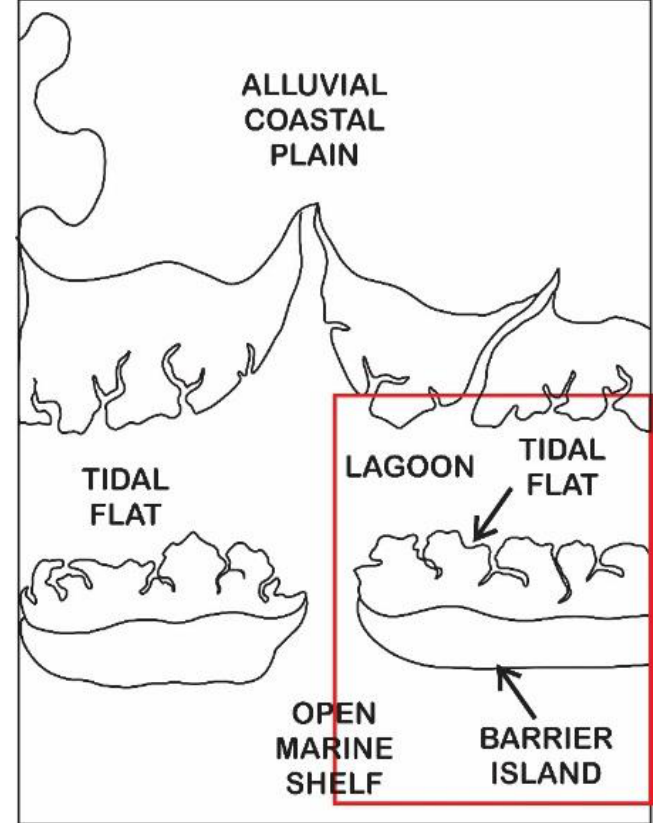
Figure 4: The environmental model of deposition is suggested ranging the area from lagoon, tidal flat and Barrier Island but it may be detached separately from fluvial system. Adaptation from Selley